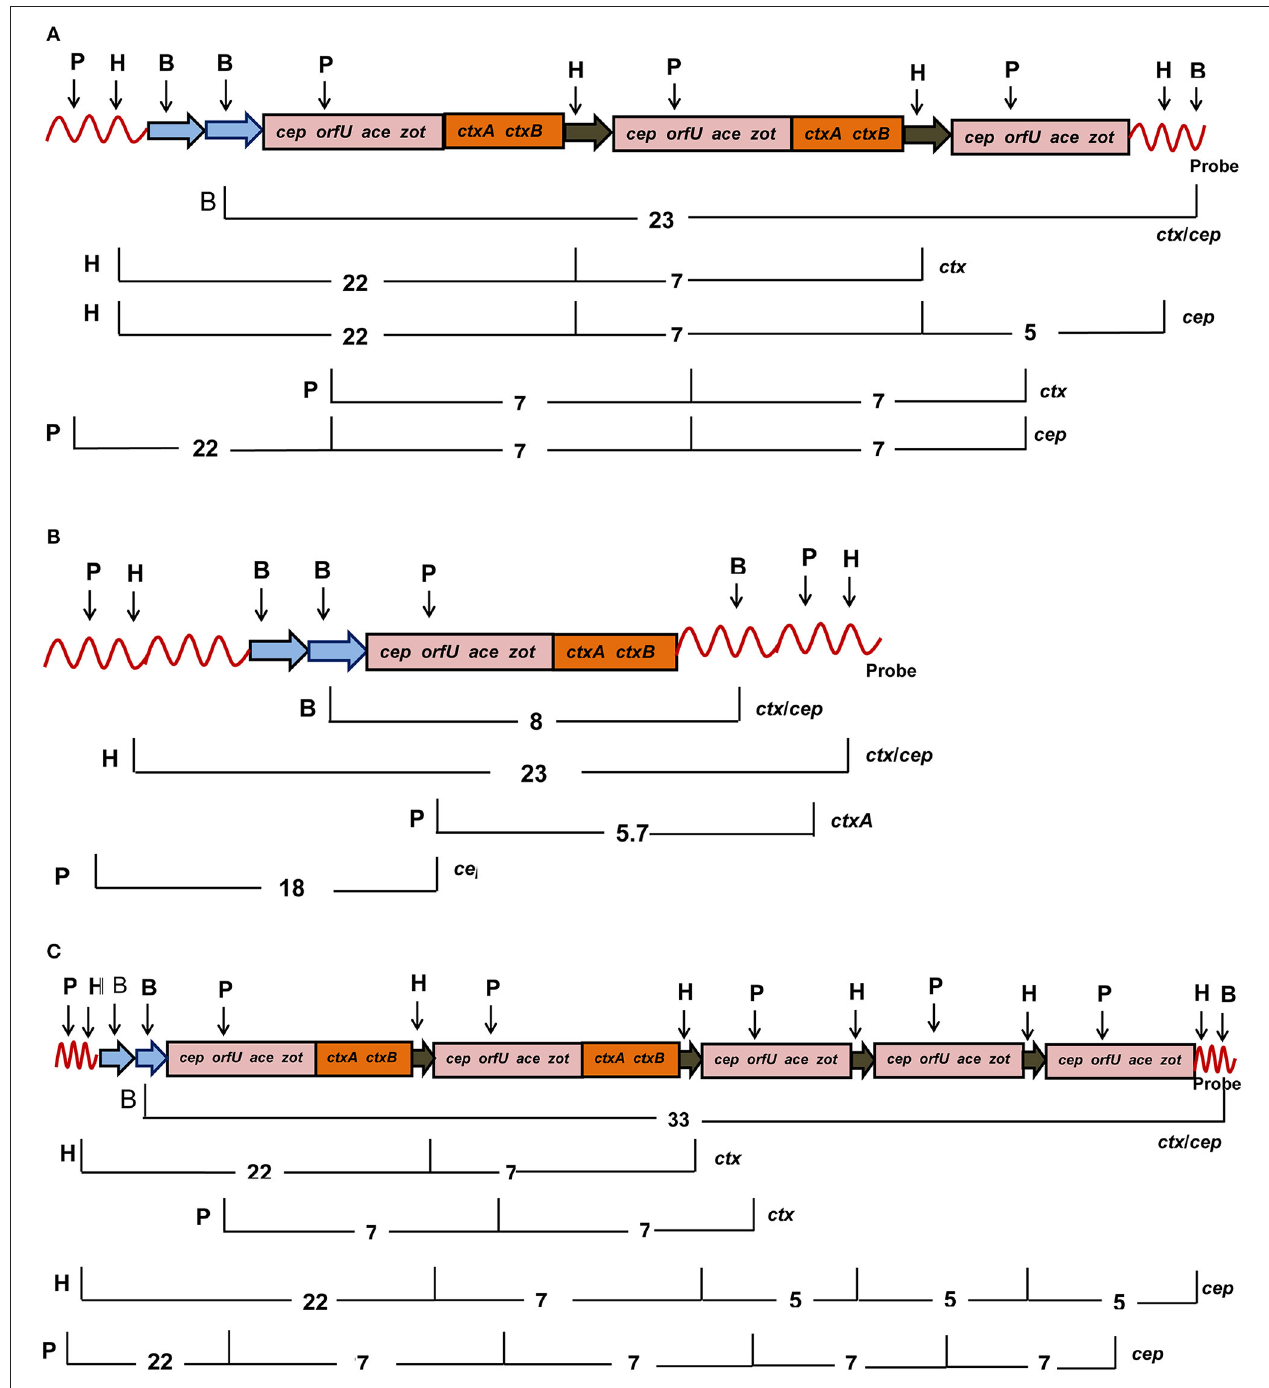
FIGURE 1 | Mapping of CTX genetic element consisting of cep, orfU, ace, zot, and ctxAB genes in V. cholerae O139 after digestion of chromosomal DNA with Hind III (H), Pst I (P), Bgl II (B), and probed with ctxA . (A) Eighteen V. cholerae O139 isolates had two intact copies (pink and brown) and one truncated CTX elements (pink). (B) Six V. cholerae O139 isolates harbored single intact copy of the CTX element (pink and brown). (C) The isolate 46 had two intact copies (pink and brown) and three copies of the truncated (pink) CTX elements. Restriction sites are abbreviated as B, H, and P for Bgl II , Hind III, and Pst I, respectively. List of probes used for hybridization was given at the right hand side. The number denotes length of the DNA fragments in Kb after digestion with the marked restriction enzymes on the left hand side.